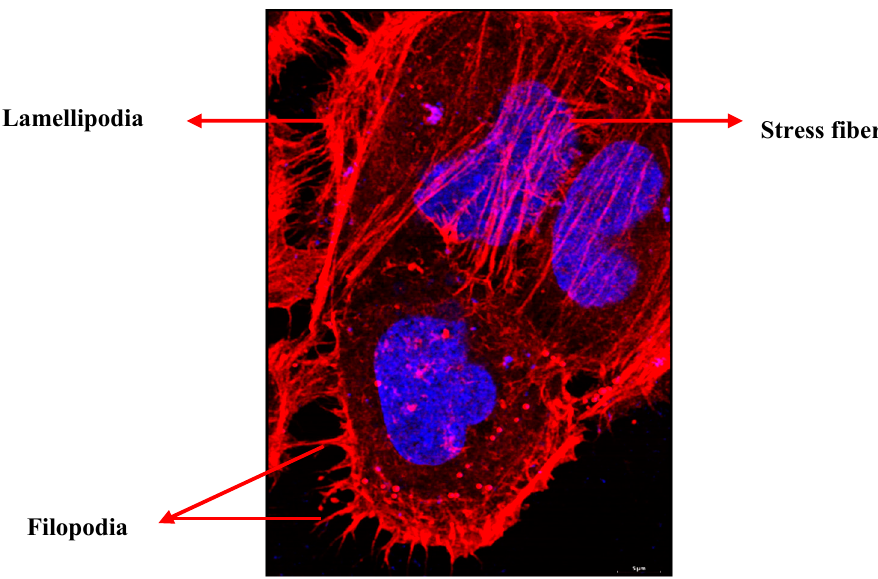
Figure 1. Immunofluorescent image of HeLa cells showing different actin structures. PFA fixed HeLa cells were stained for actin (red) (Phalloidin 647) and image was taken using airy scan mode in Zeiss 800 confocal microscope using 63× objective. Nucleus is shown in blue (blue). Scale bar = 5 µm.